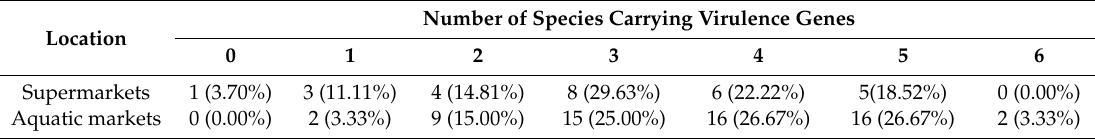
Table 6. Comparison of virulence genes of A. veronii isolated from di ff erent sampling locations.